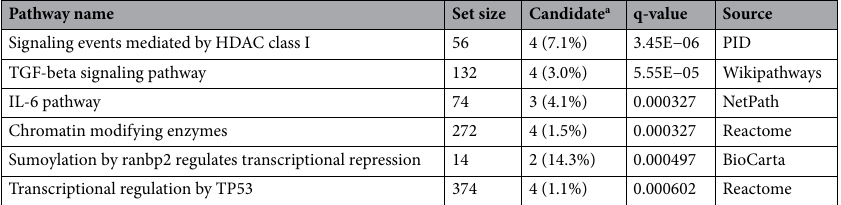
Table 3. Significant pathways associated with ARDS mortality using the Network approach . a Numbers of genes in the pathway are from the 9 genes identified through the Network approach.